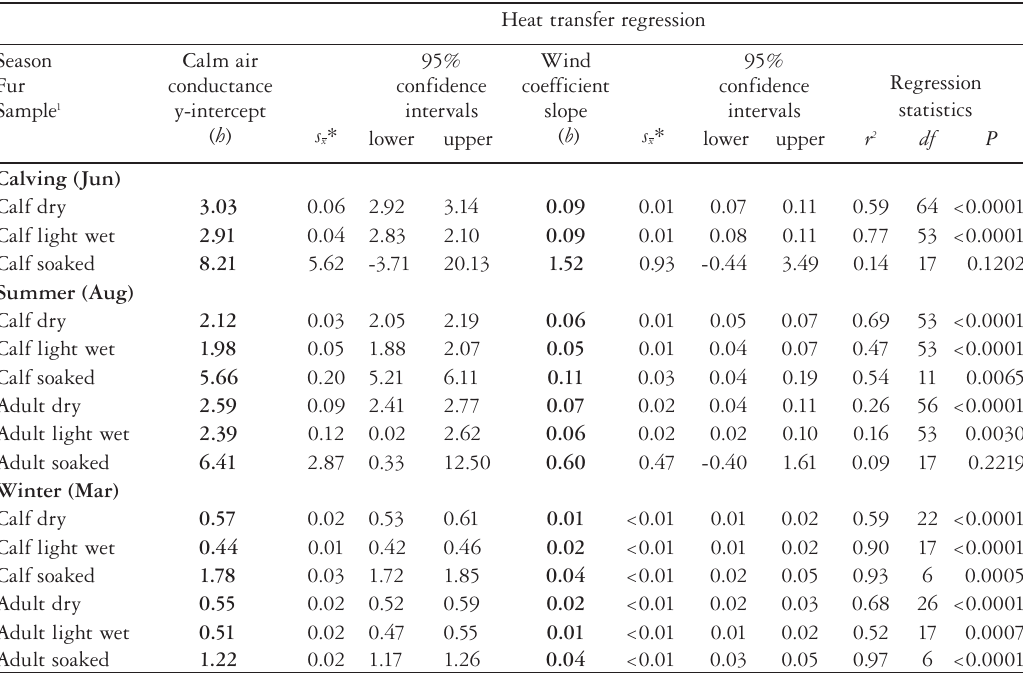
Heat transfer regression